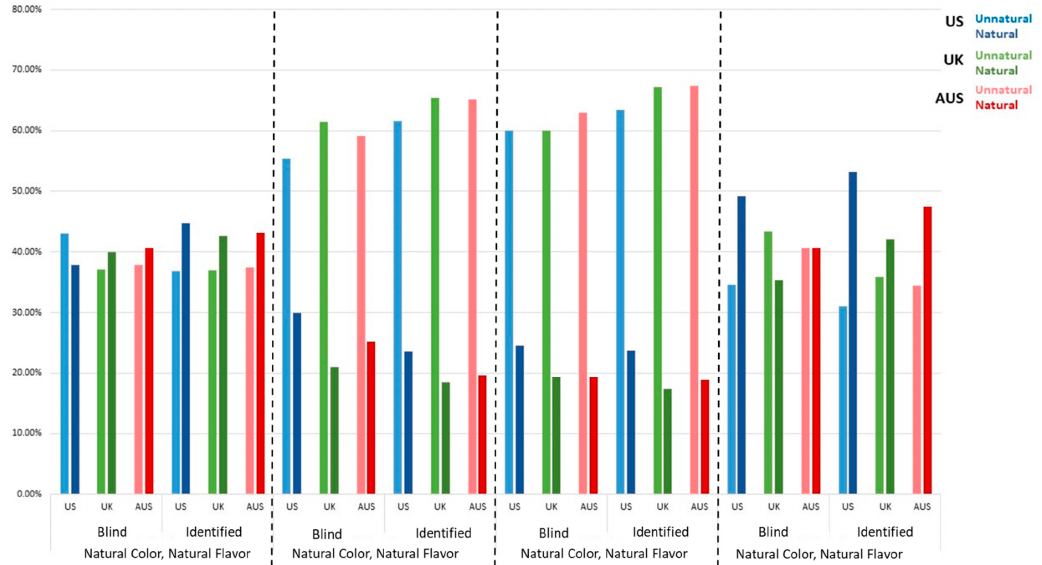
Figure 1. Percentage of US, UK, and AUS respondents who rated products represented by ingredient statements with natural or artificial colors or flavors as natural or unnatural.